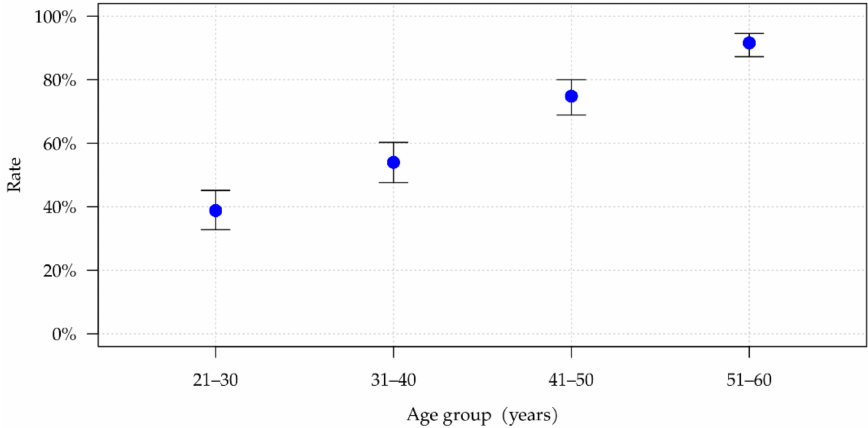
Figure 2. Percentage of degenerated disc segments per age group with relevant 95% confidence intervals. Table 2. Frequency and extent of segment degeneration by age group (number of degenerated segments per age group and average positive individual markers of degeneration per segment).